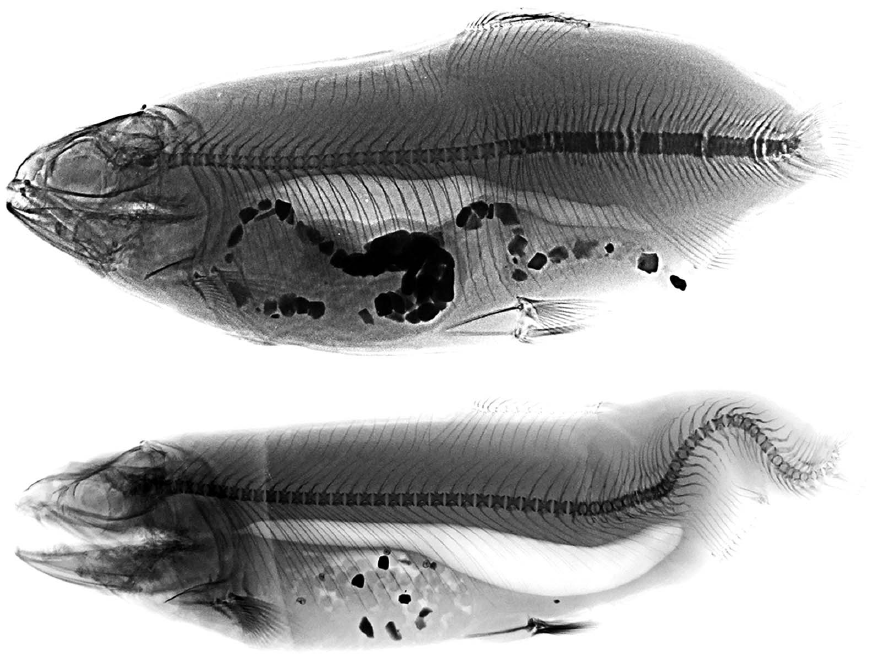
Figure 1. Rainbow trout specimens affected by commercially severe anomalies. Specimen with stumpy body due to scoliosis and compressed hemal and caudal vertebrae, and specimen affected by kypho-lordosis in the hemal and caudal vertebrae. Some hemal vertebrae are compressed and fused.